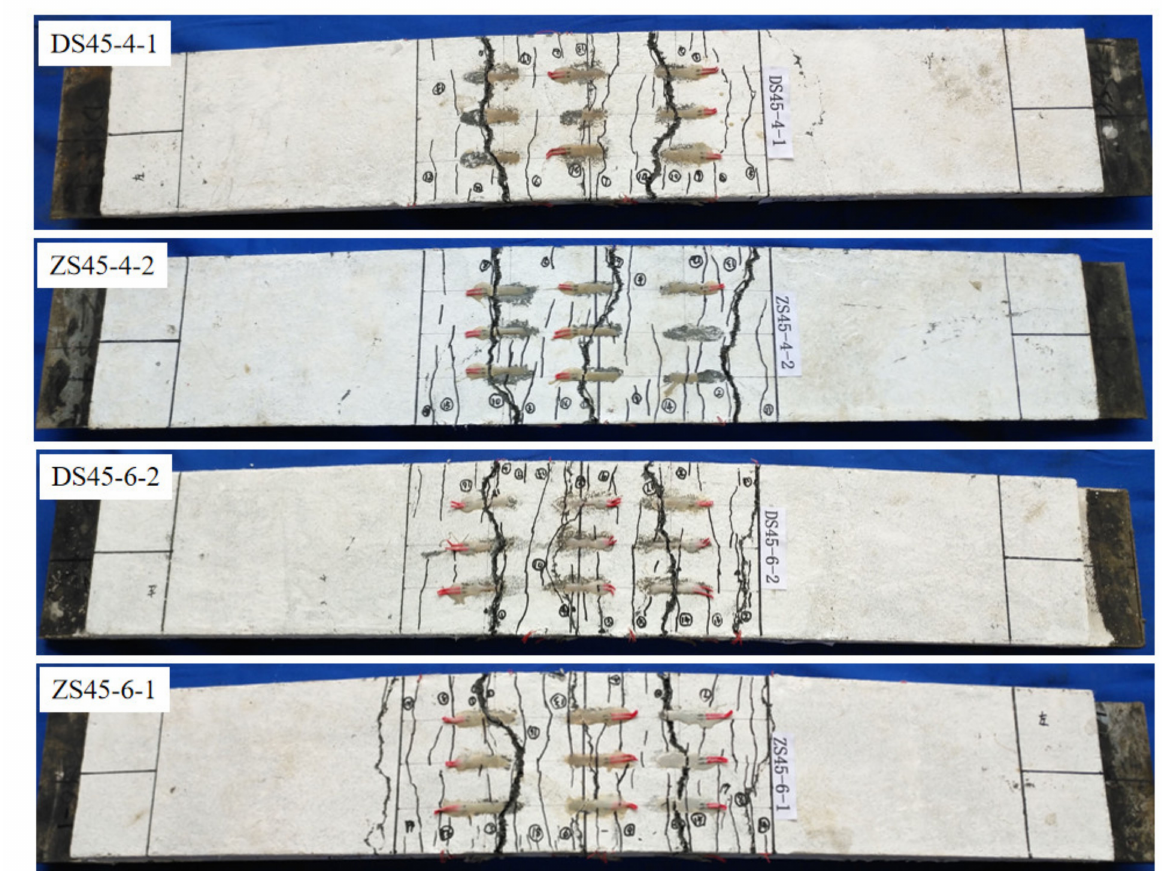
Figure 13. Photos of some damaged